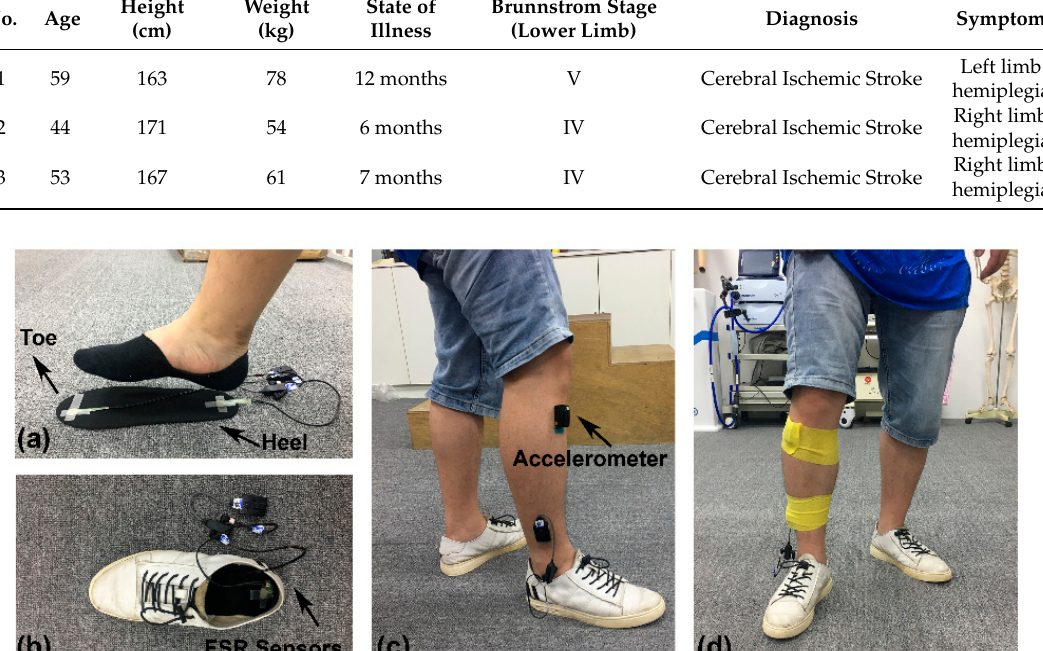
Figure 1. Experimental setup for force sensitive resistor (FSR) and accelerometer sensors placement in preparation for gait data acquisition. ( a ) A pair of FSR sensors were placed under the big toe and heel of the insole; ( b ) the placement of the insole into the shoe; ( c ) the placement of the accelerometer on the tibialis anterior muscle under the knee joint of right leg; ( d ) a bandage was used to firmly fix the sensors.